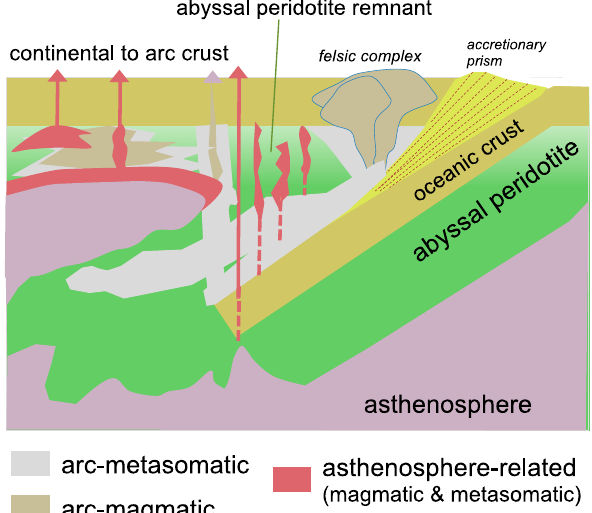
Figure 14. Cartoon to illustrate the evolution of mantle wedge after initiation of subduction. Arc-type magmas, slab-derived fluids and asthenospheric mgamas have modified the initial abyssal peridotite to various degrees through repeated subduction and break of slab after entrapment. The abyssal peridotite remnant, which has been devoid of the modification, is one of the important components of the mantle